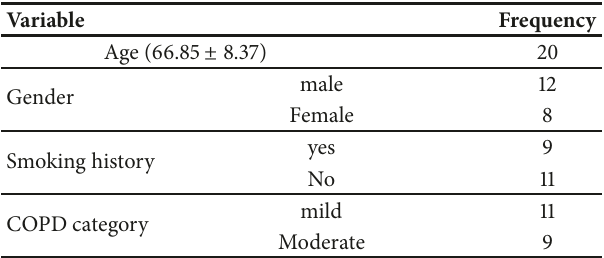
Table 1: Demographic data of